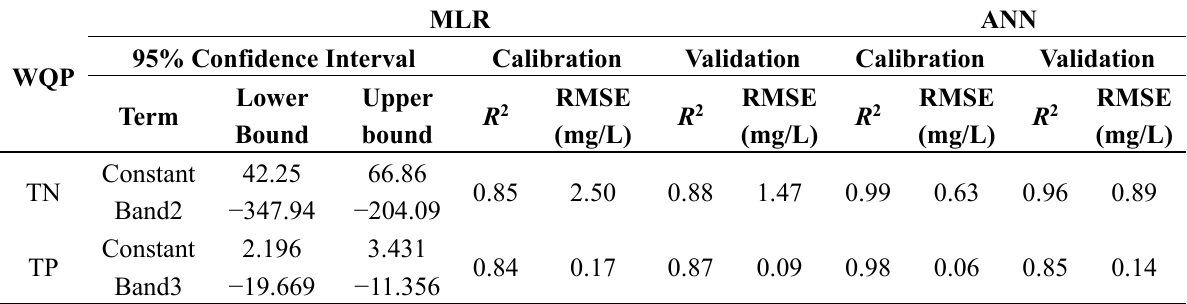
Table 6. Comparison of inversion accuracy of MLR middle and ANN model. MLR ANN 95% Confidence Interval Calibration Validation Calibration WQP